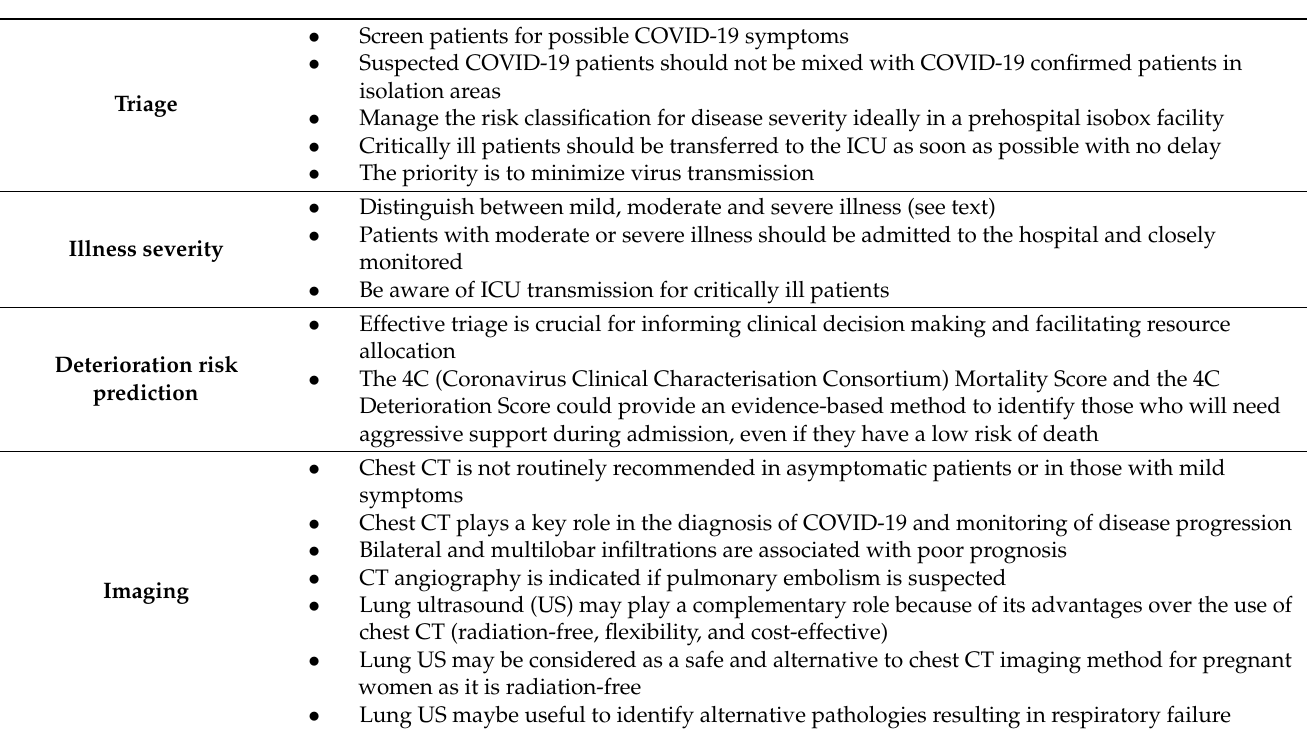
Table 2. Evidence based recommendations for management of COVID-19 patients in the ED.